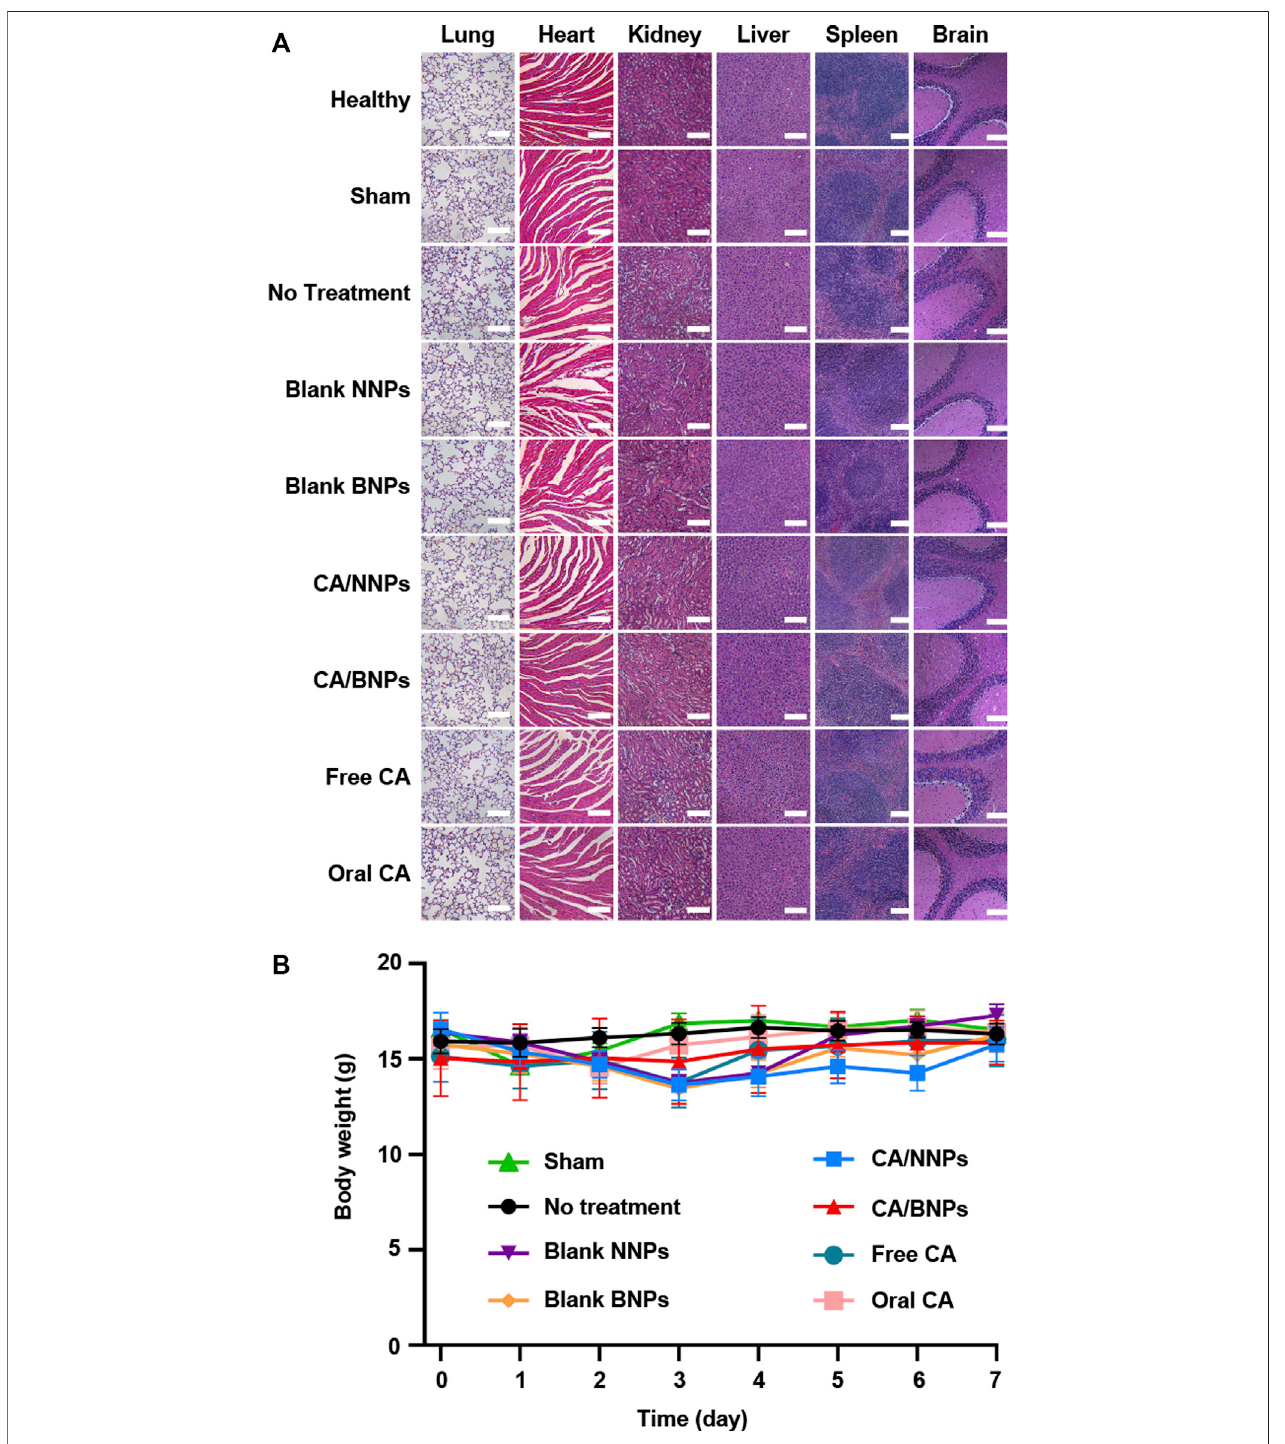
FIGURE 6 | In vivo toxicity evaluation. (A) H&E staining of the major organs of the mice 7 days after different treatments (scale bar = 500 nm). (B) Body weight changes of mice in different groups.